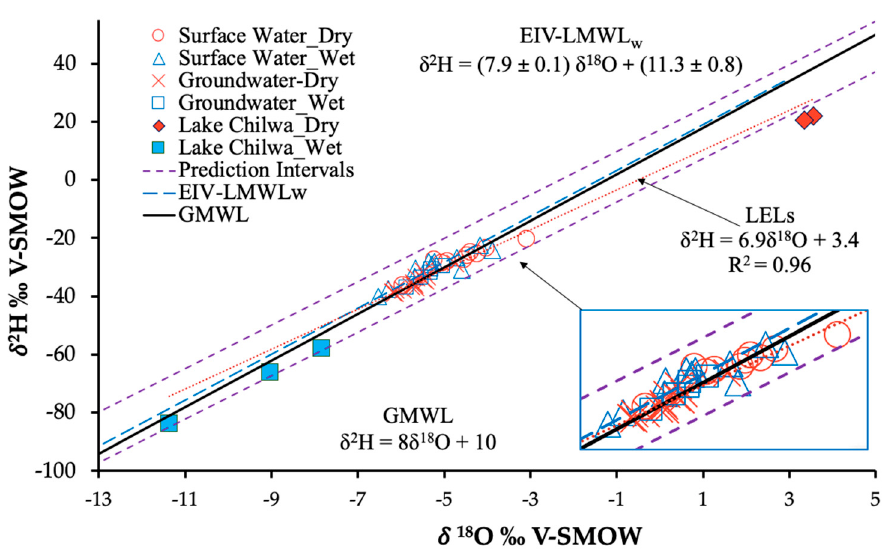
Figure 7. Plot of 𝛿 2 H versus 𝛿 18 O for groundwater, surface water and Lake Chilwa isotopic samples. Figure 7. Plot of δ 2 H versus δ 18 O for groundwater, surface water and Lake Chilwa isotopic